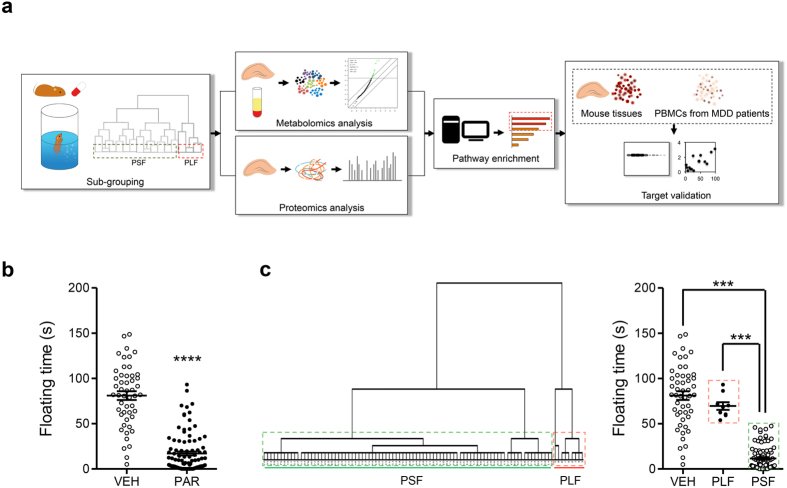
Sub-grouping of paroxetine-treated mice.(a) A schematic overview of the workflow. (b) Male DBA/2J mice received paroxetine (5 mg/kg, twice a day, 28 days) and floating time was recorded for 6 min. PAR mice displayed significantly shorter floating time compared to vehicle-treated group (VEH). n(VEH/PAR) = 50/95. (c) Dendrogram of paroxetine-treated mice. Mice treated with paroxetine were separated into PLF and PSF groups using hierarchical clustering analysis (HCA). n(VEH/PLF/PSF) = 50/9/86. Data are expressed as mean ± SEM. ***p < 0.001 (one-way ANOVA with Tukey’s test for multiple comparisons), ****p < 0.0001 (two-tailed t-test).